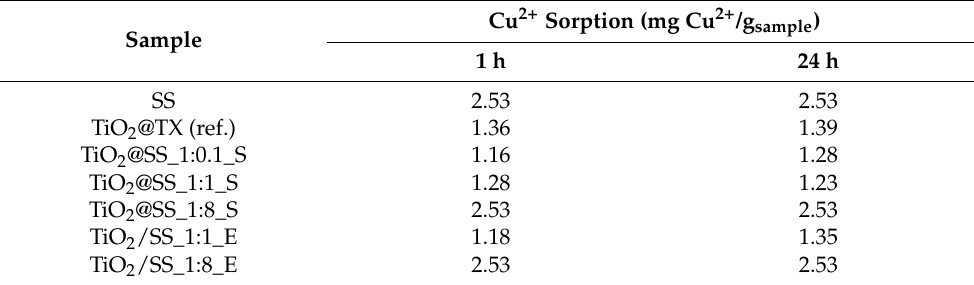
Table 5. Results of Cu 2+ sorption (mgCu 2+ /g sample ) tests performed on representative samples.